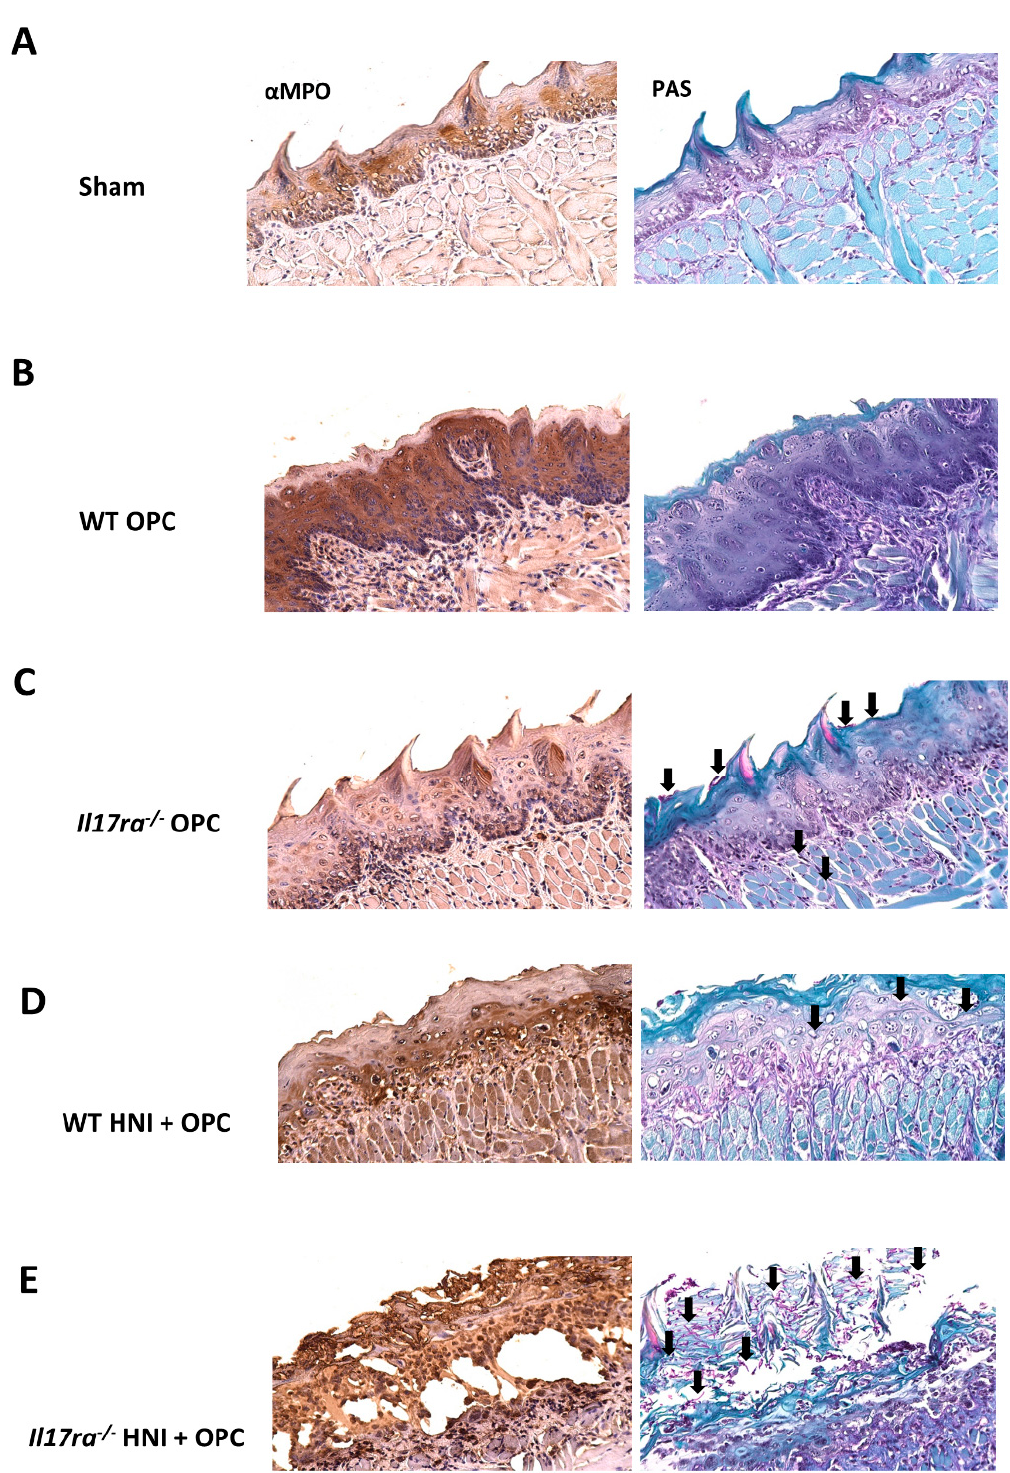
Figure 7. Higher MPO levels throughout the epithelial layers of the tongue tissue in the presence of C. albicans . ( A – E ) Representative MPO-staining of ulcer boundary region counterstained with hematoxylin. Serial section was stained with PAS to visualize C. albicans and counterstained with Fast Blue. Images taken at 20 × magnification. Arrows indicate examples of C. albicans . Images representative of 3 mice per group and 3 experimental repeats.